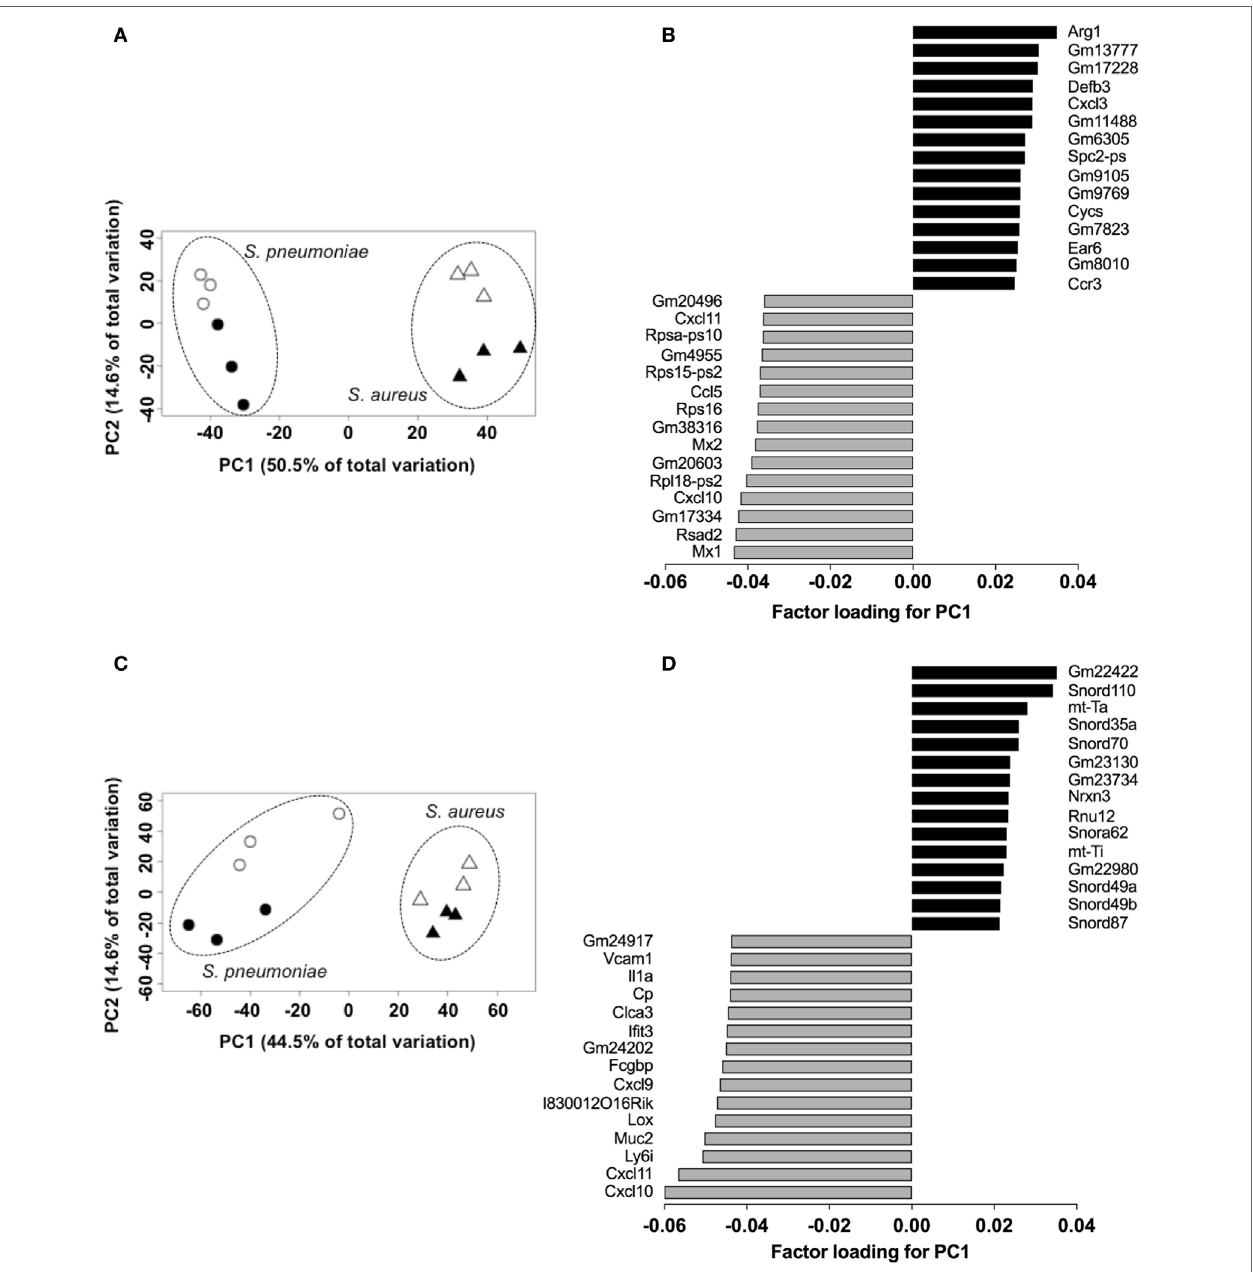
FigUre 3 | Pathogen-specific transcriptional signatures in lung tissue and peripheral whole blood of infected mice. Principal component analysis of the transcription data of Streptococcus pneumoniae- infected (circles) and Staphylococcus aureus- infected (triangles) lungs at 24 h (open symbols) and 48 h (solid symbols) of infection in lungs (a) and blood (c) . Each symbol represents one independent experiment. Factor loading for PC1 analysis of lungs (B) and blood (D) transcription data. Black bars represent genes expressed to a greater extent in S. aureus- infected samples whereas gray bars represent genes expressed to a greater extent in S. pneumoniae- infected